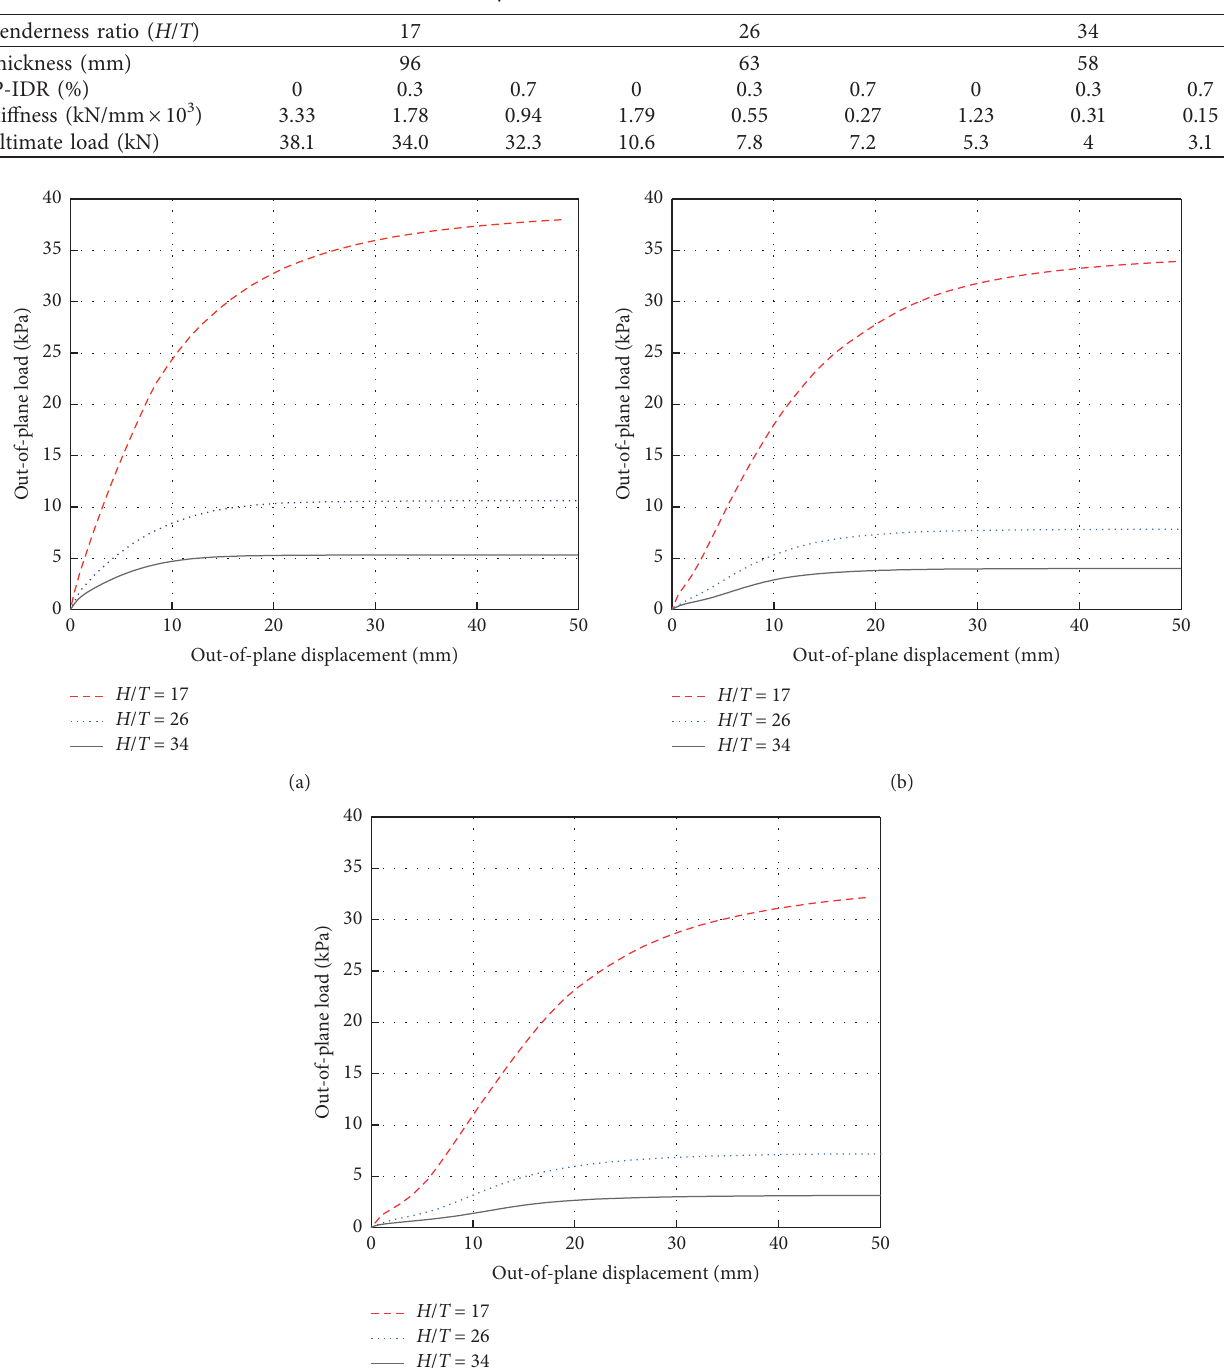
Table 5: The information and analysis results of infill walls with different slenderness ratios.